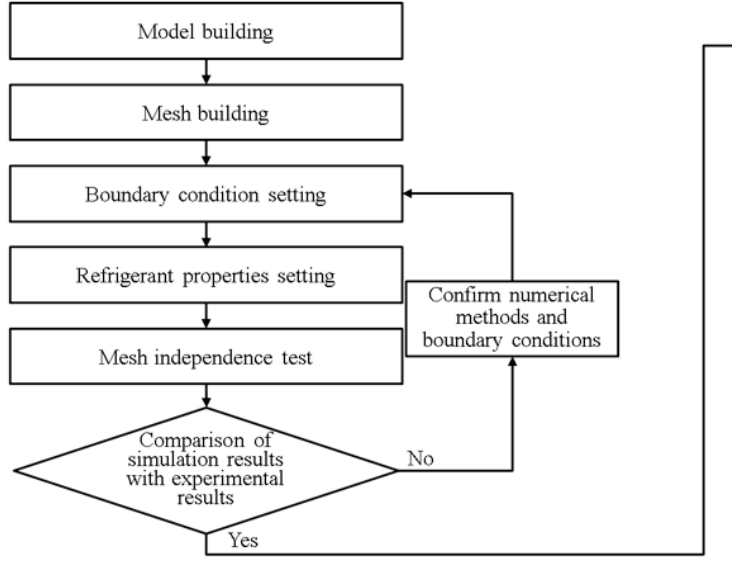
Figure 4. Flow field simulation analysis structure diagram .